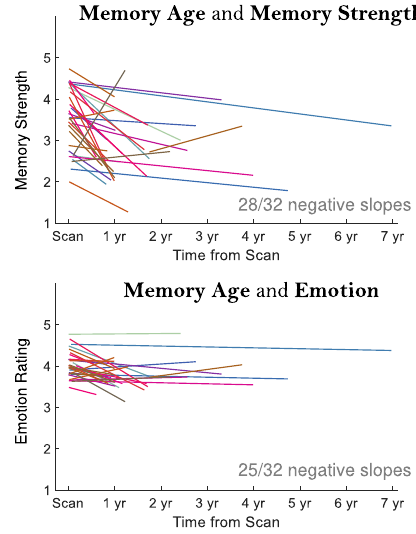
strength (i.e., older memories were less strongly remembered). In 30 out of 32samples,distancehad apositive relationshipwithmemorystrength(i.e.,farther memories were more strongly remembered). In 25 out of 32 samples, age had a negative relationship with emotion (i.e., older memories had weaker emotions). In